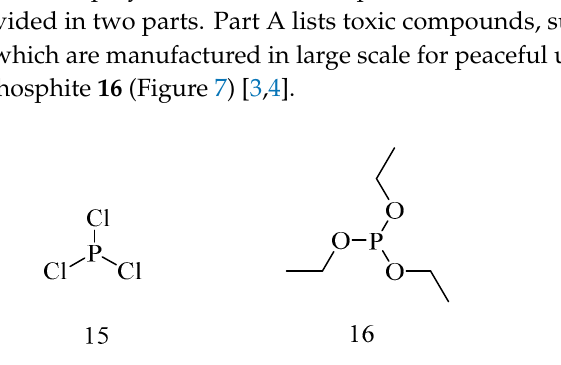
Figure 7. Phosphorus trichloride and triethyl phosphite.